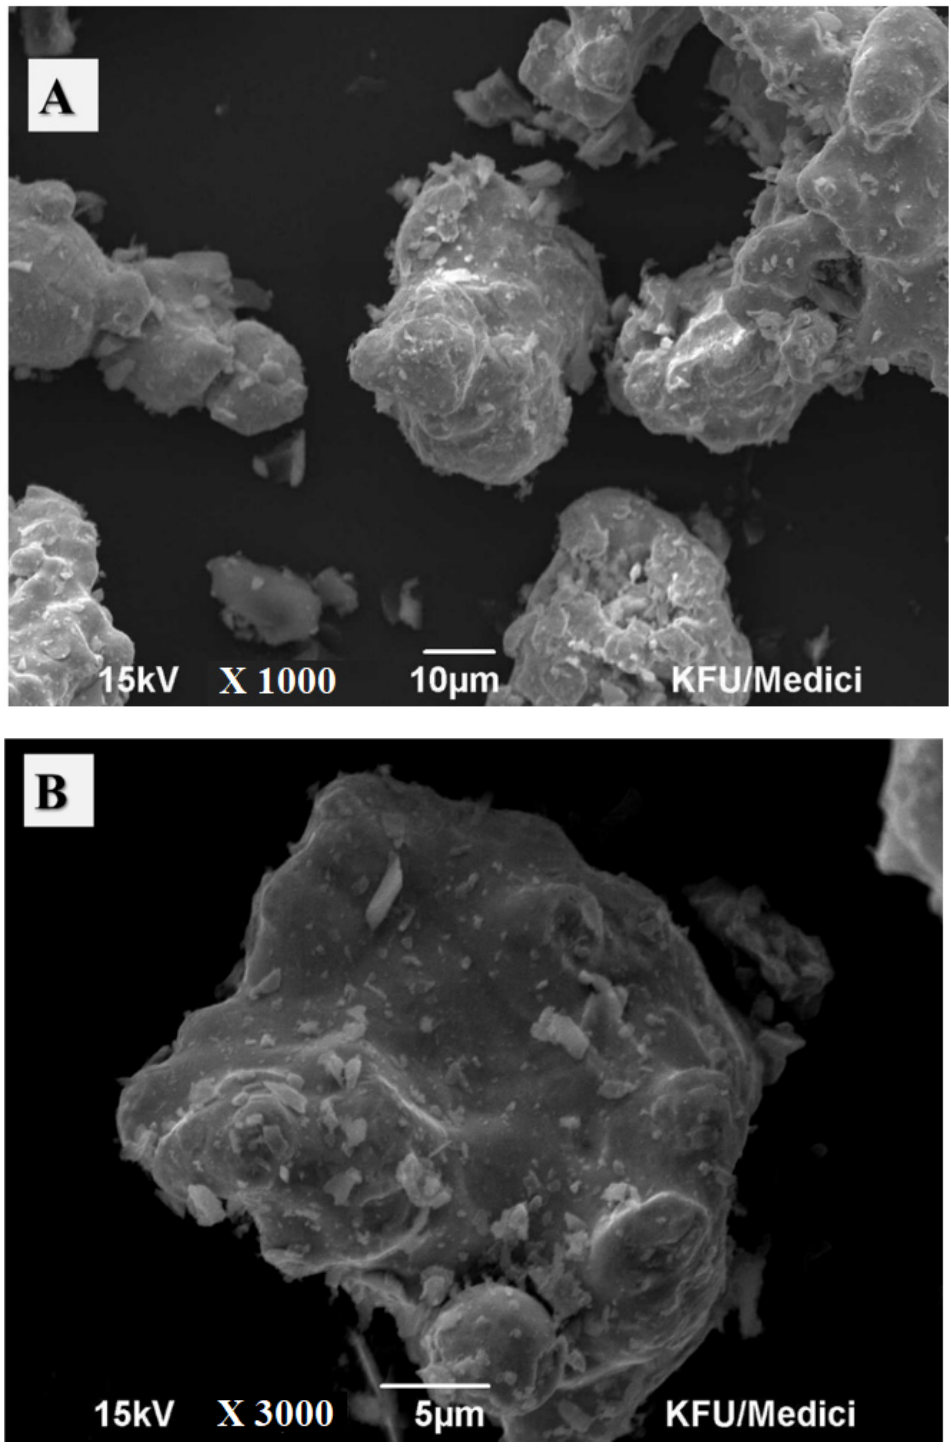
Figure 7. SEM images of the prepared Fe(0)@AC adsorbent after adsorption experiment ( A ) and before adsorption experiment ( B ).